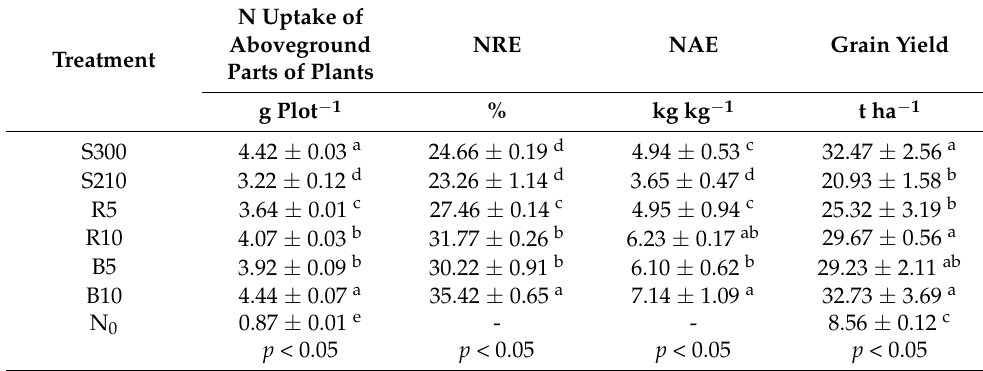
Table 3. Effects of different fertilization methods on grain yield and N use